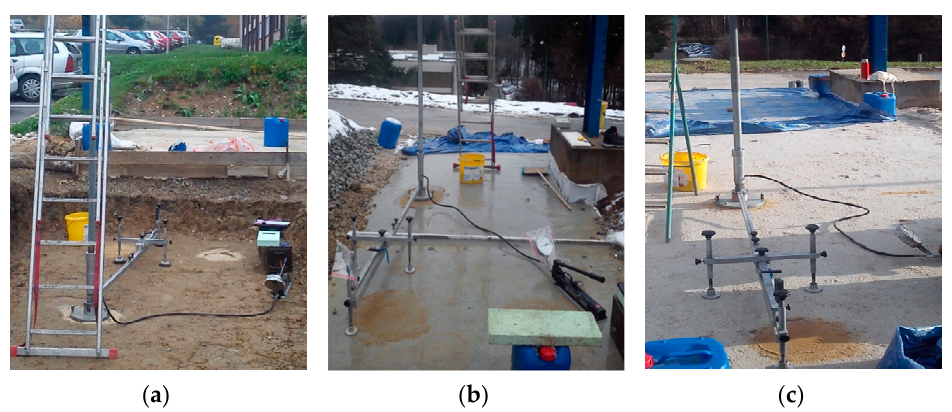
Figure 4. Experimental field—load capacity test on ( a ) the subsoil, ( b ) layer of foamed concrete, and ( c ) ballast bed.